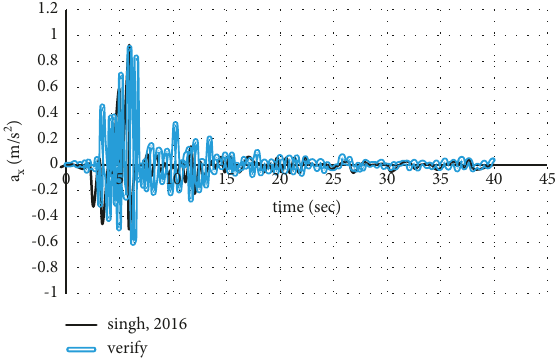
singh, 2016 Figure 4: Comparison of validation time history analysis with Singh et al.’s paper for Delhi Metro tunnel to accelerate the point corresponding to the image of the center of the tunnel to the ground